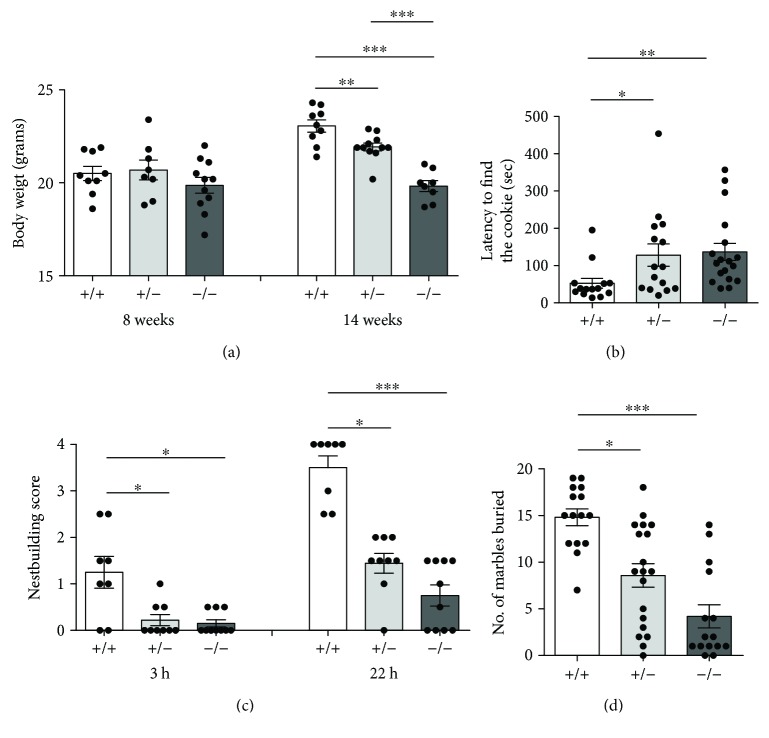
Reduced body weight, impaired olfaction, and autistic-like features in Cdkl5 +/− female mice. (a) Body weight at 8 and 14 weeks of age in Cdkl5 +/+ (n = 9), Cdkl5 +/− (n = 8 and n = 11, resp.), and Cdkl5 −/− (n = 11 and n = 8, resp.) mice. Only at 14 weeks of age Cdkl5 +/− and Cdkl5 −/− mice showed reduced body weight compared to Cdkl5 +/+ mice. (b) Olfactory ability evaluated using the buried food test. Cdkl5 +/− (n = 15) and Cdkl5 −/− (n = 18) mice showed an increased latency to find the buried cookie compared to Cdkl5 +/+ mice (n = 14), indicating olfactory impairment in Cdkl5 +/− and Cdkl5 −/− mice. (c) Nest building ability evaluated at 3 and 22 h. Cdkl5 +/− (n = 9) and Cdkl5 −/− (n = 10) mice showed impaired nesting behavior compared to Cdkl5 +/+ (n = 8) mice. (d) Marble burying test. Cdkl5 +/− (n = 19) and Cdkl5 −/− (n = 15) mice buried fewer marbles compared to Cdkl5 +/+ mice (n = 15). Values represent mean ± SEM. ∗
p < 0.05, ∗∗
p < 0.01, and ∗∗∗
p < 0.001 (datasets in (a), Fisher's LSD test after ANOVA; datasets in (b–d), Dunn's test after Kruskal-Wallis).